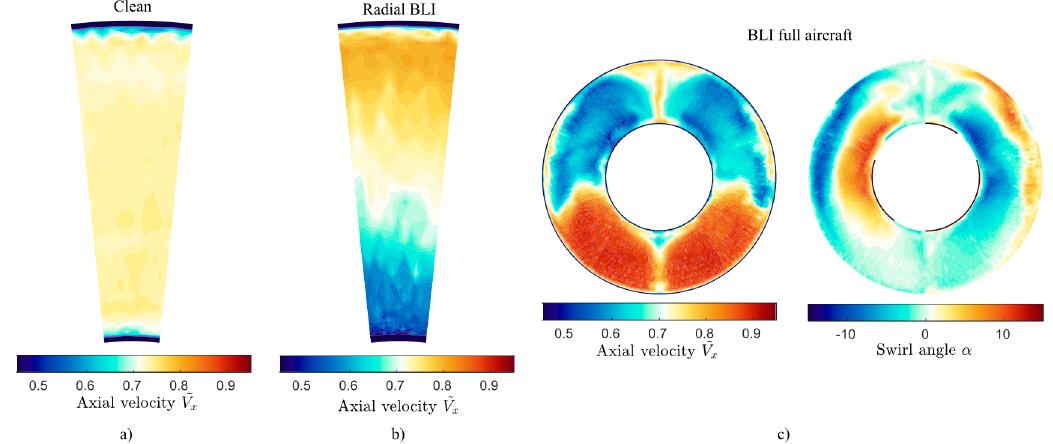
Figure 18. Measured inlet inflow behind the distortion gauzes: ( a ) Clean, ( b ) hub-low distortion, ( c ) full-aircraft configuration.